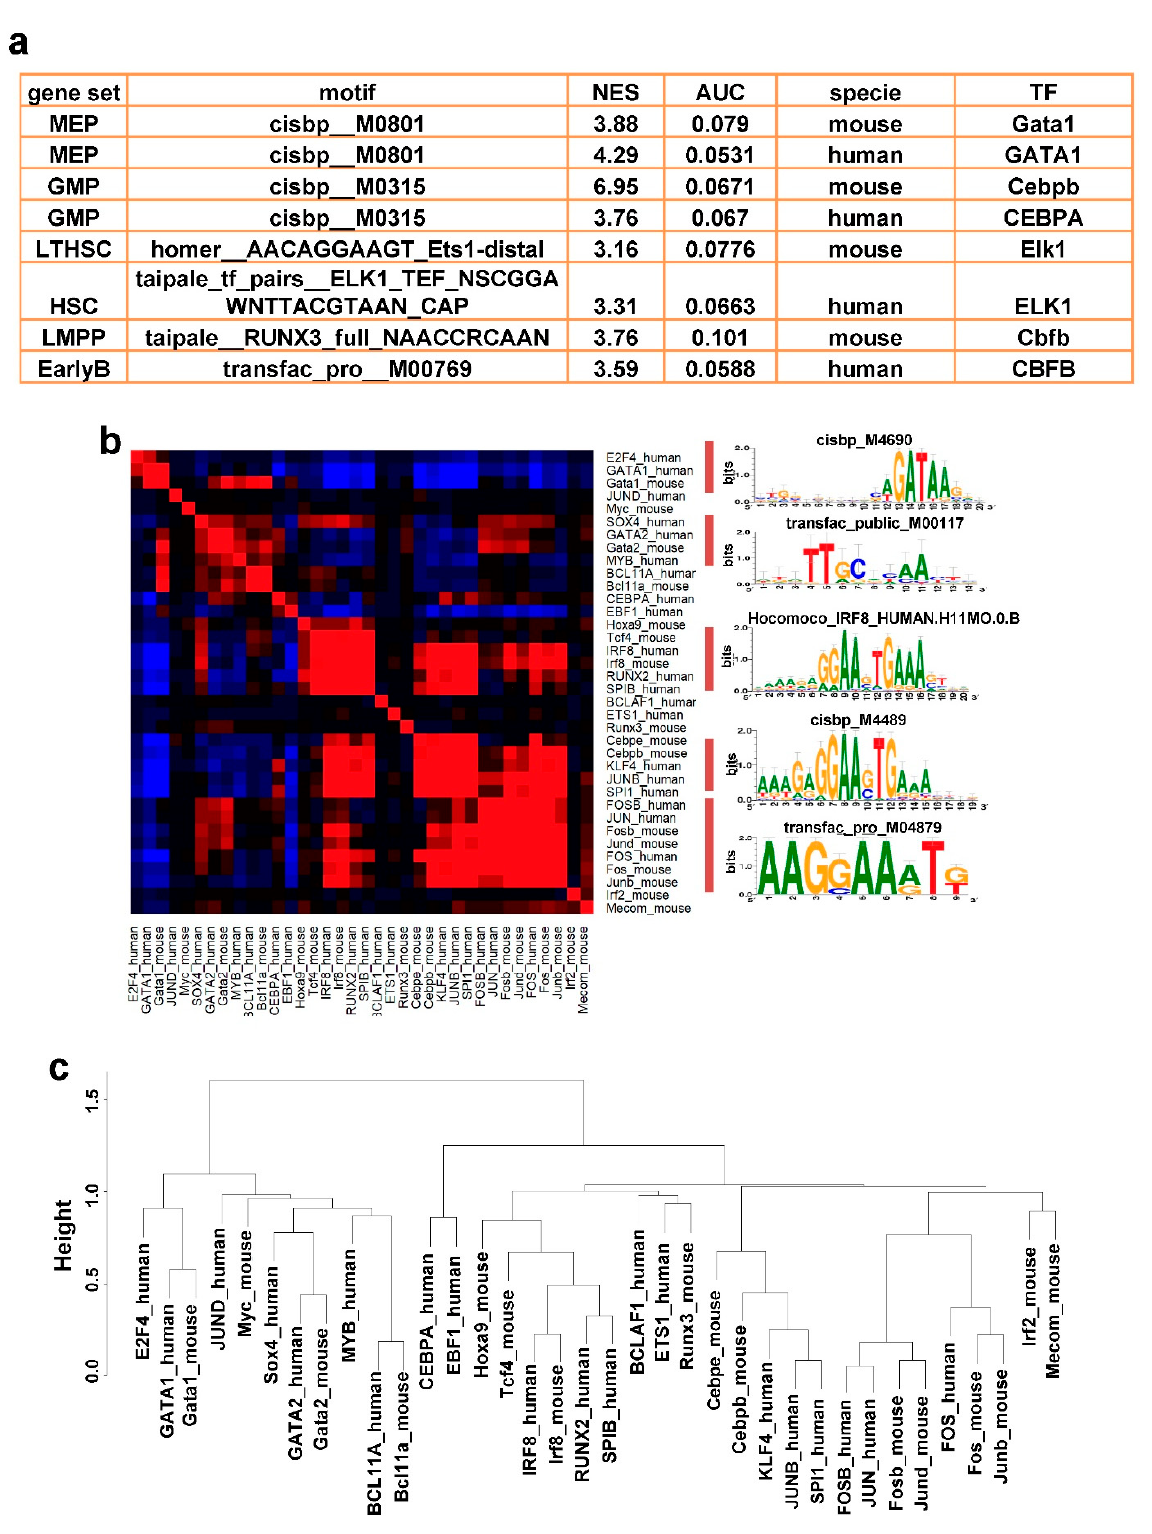
Figure 4. ( a ) A table of enriched motifs by RcisTarget for selected sets of regulons related to cell populations in human and mouse, generated within the SCENIC workflow. ( b ) Average AUCell scores of all human and mouse cells were calculated with the identified regulons to obtain a regulon-cell matrix. Then, the distance among regulons was hierarchically clustered. The corresponding binding motifs were shown on the right. Regulons were grouped into several major modules, along with representative TF regulons and associated cell types. ( c ) A clustering dendrogram shows the relationships of 37 orthologous TF regulons.